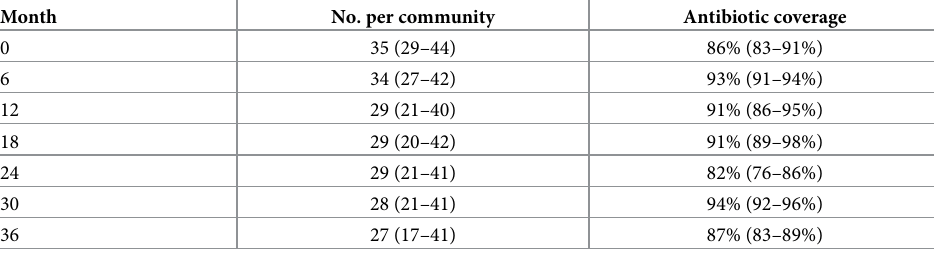
Table 2. Azithromycin coverage among population aged 6–59 months of age in 12 biannually treated communities.